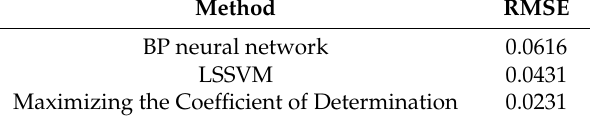
Table 5. The comparison of the RMSE between the three modelling